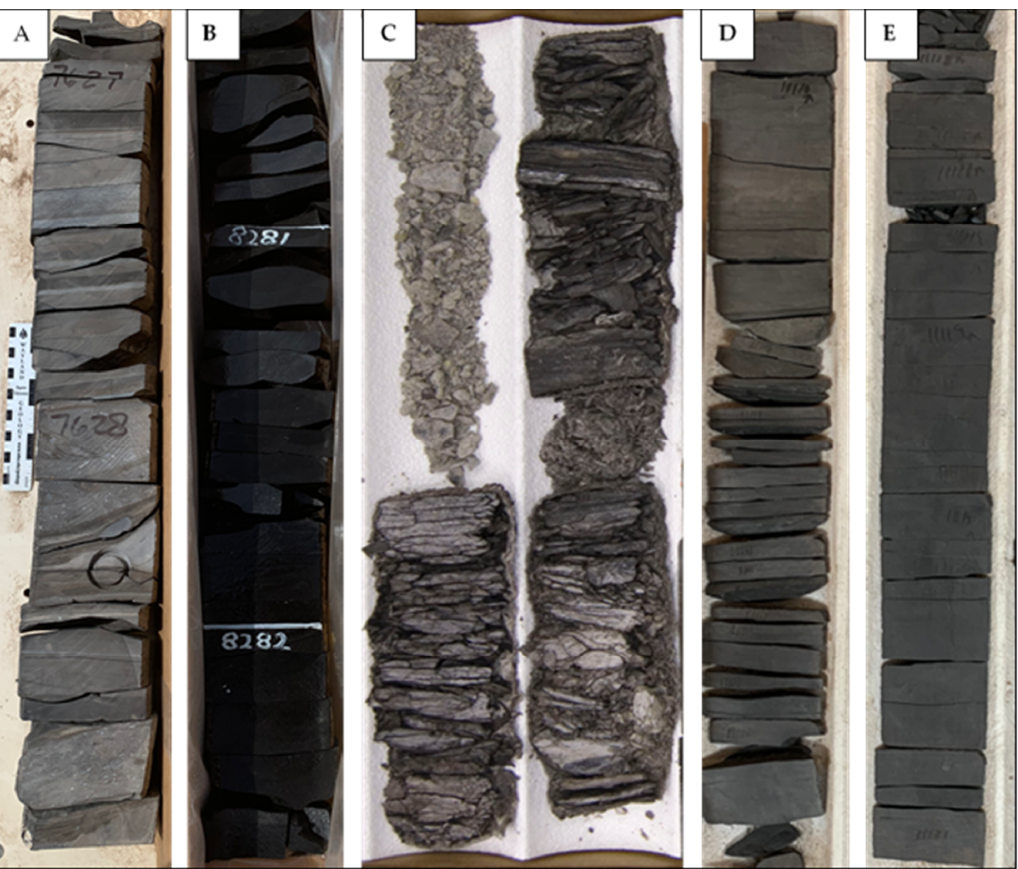
Figure 5. Lithofacies within the Tonya 901 ( A , B ), Tonya 401 ( C ), and JP Chilton ( D , E ) cores. ( A ) Interbedded Si-rich and Ca-rich shale. ( B ) Si-rich black shale. ( C ) Green-grey siltstone and claystone. ( D ) Ca-rich shale. ( E ). Si-rich shale.